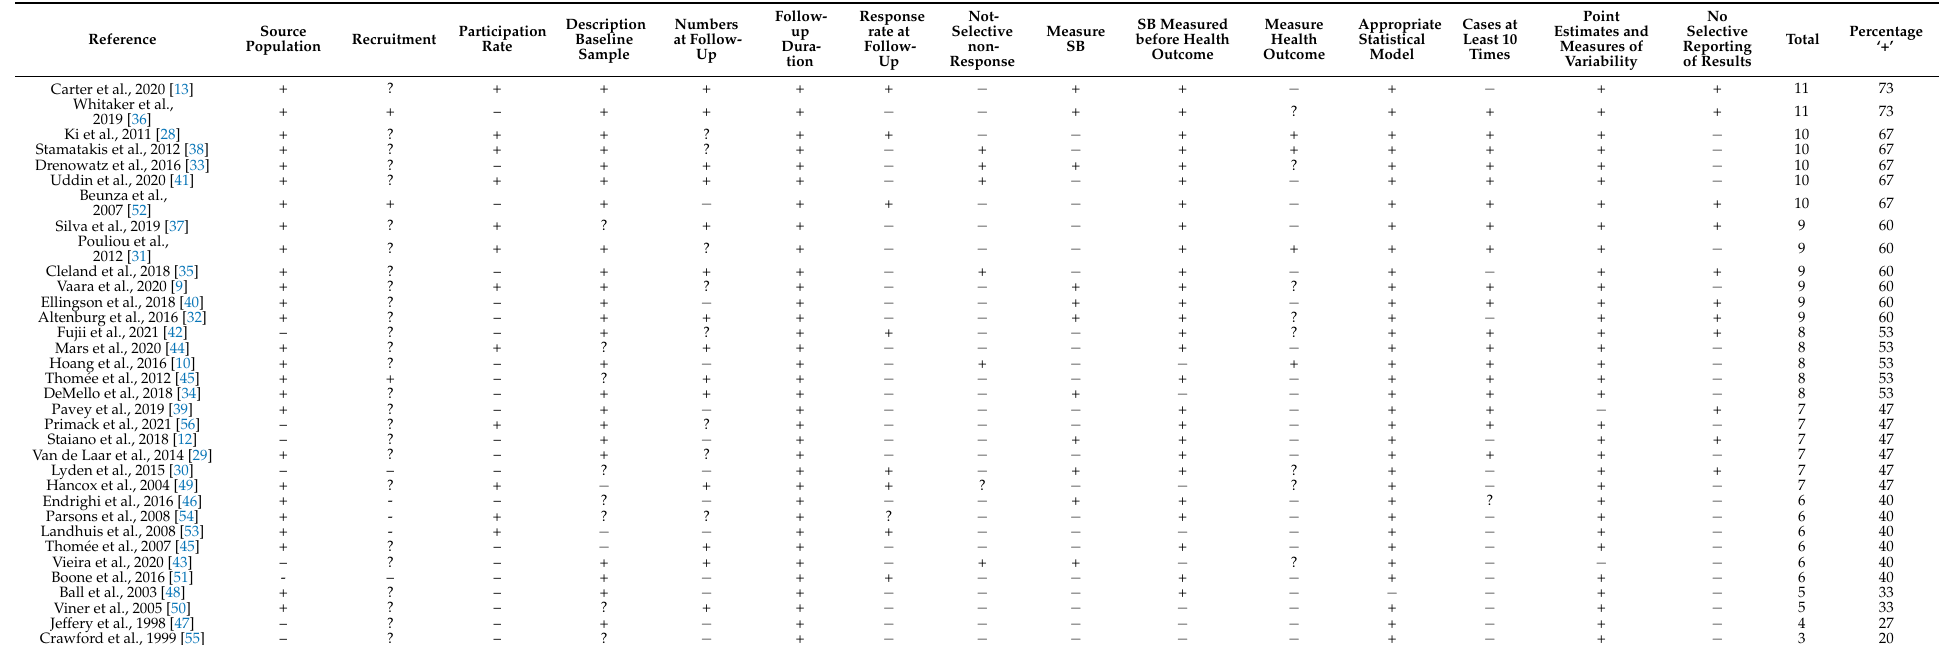
Table 2. The overall scores of the methodological quality assessment for the included